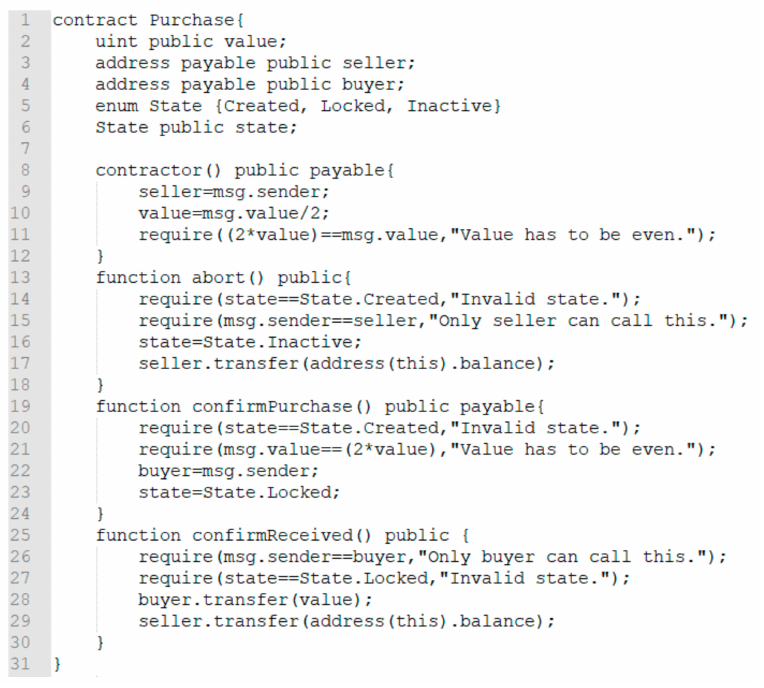
Figure 7. Source code of a solidity